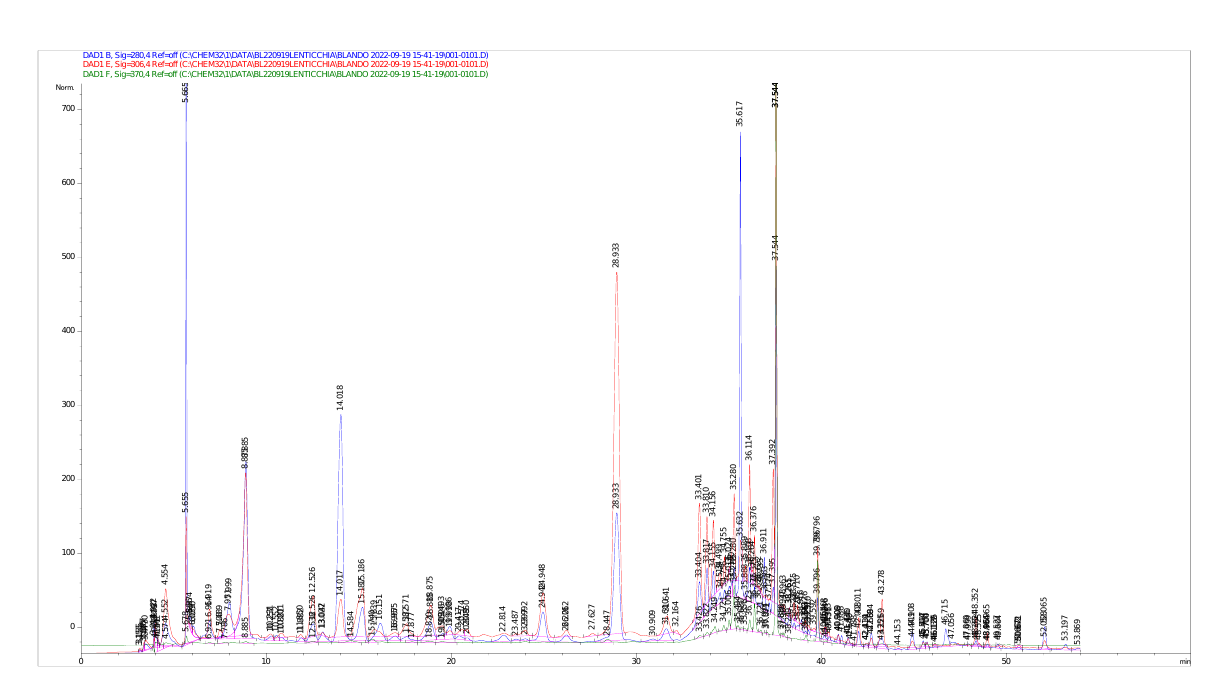
Figure A2. Chromatogram of flavonoids identified on the basis of RT and absorption spectra in the extracts of lentil 6002/ILWL118/1-1.